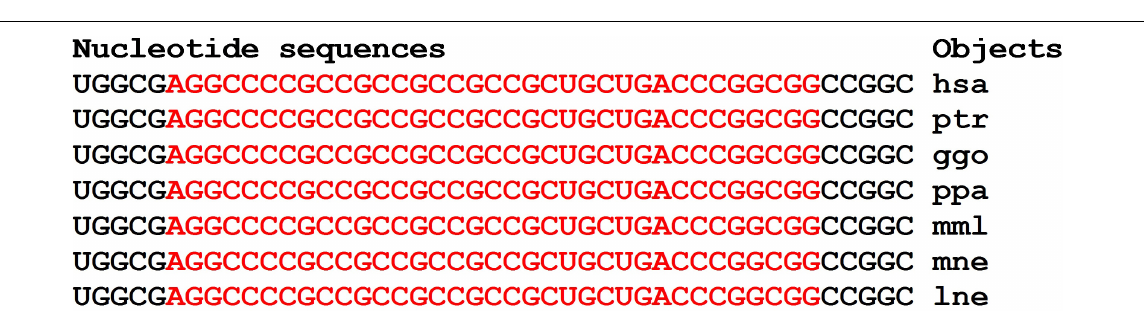
FIGURE 5 | Nucleotide sequences of 5 (cid:48) UTR regions of mRNAs of orthologous ZFAND4 genes containing a cluster of miRNAs binding sites.